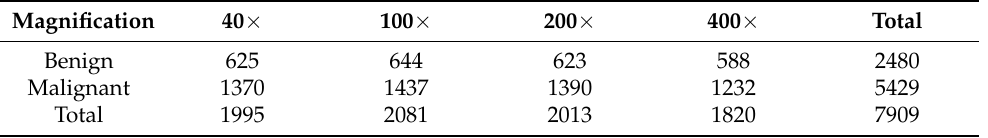
Table 1. Split of the BreakHis dataset by magnification and classes.